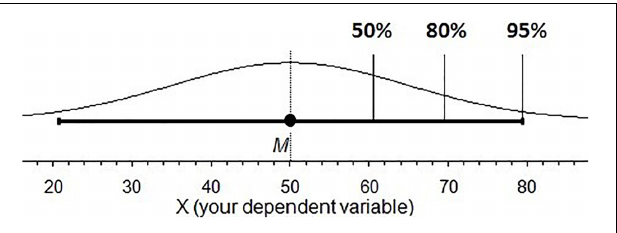
FIGURE 5 | The likelihood distribution of each point of a 95% CI landing on µ . The 50, 80, and 95% marks indicate the upper limit of the CI with each of those C% levels.